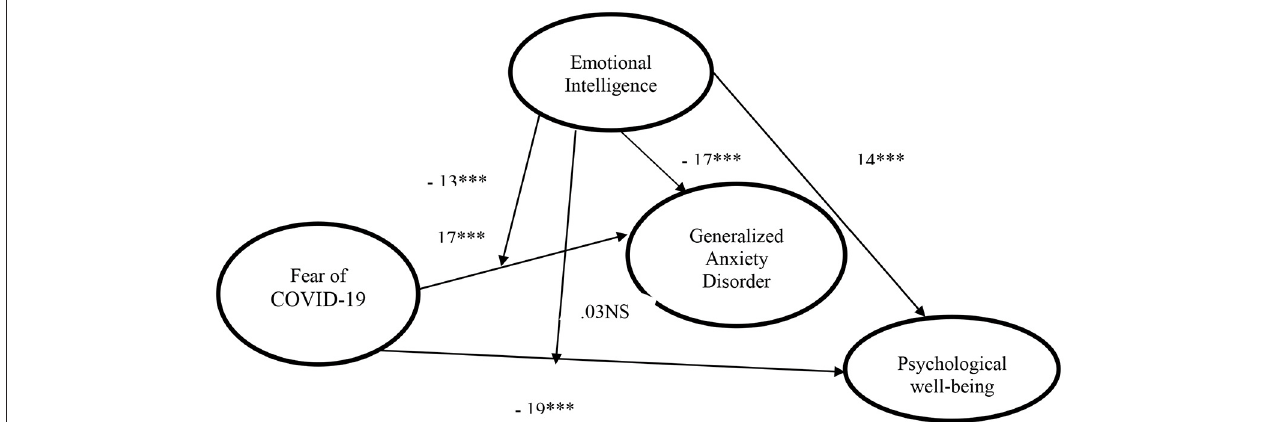
FIGURE 2 | Results of the model, *** p < 0.001; NS, non-significant.